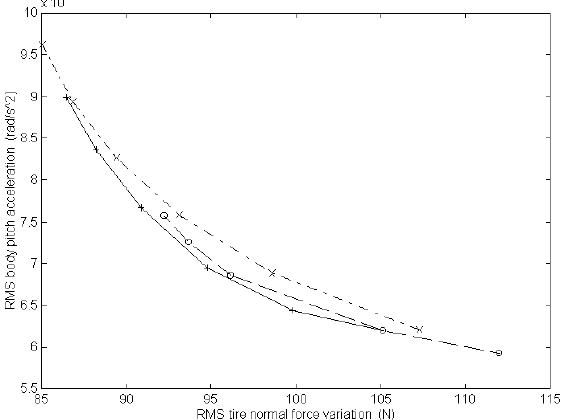
Figure 9. Tire normal force variation vs. pitch acceleration.